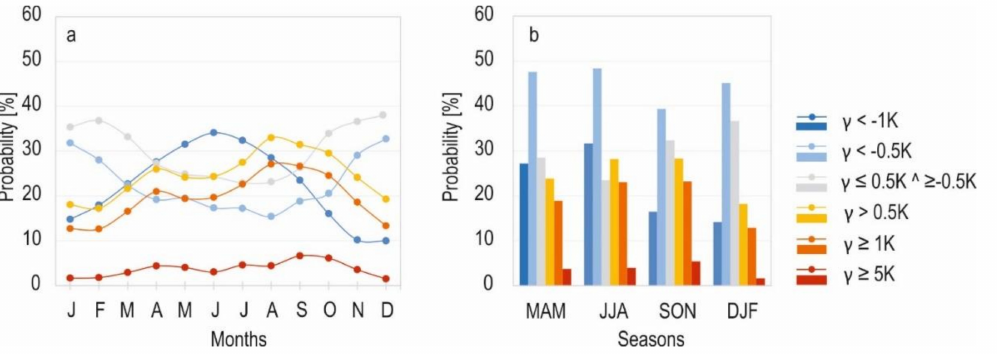
Figure 4. Monthly ( a ) and seasonal ( b ) variability in probability of air temperature gradients ( γ ).